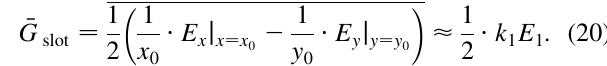
components and the G x;y;z